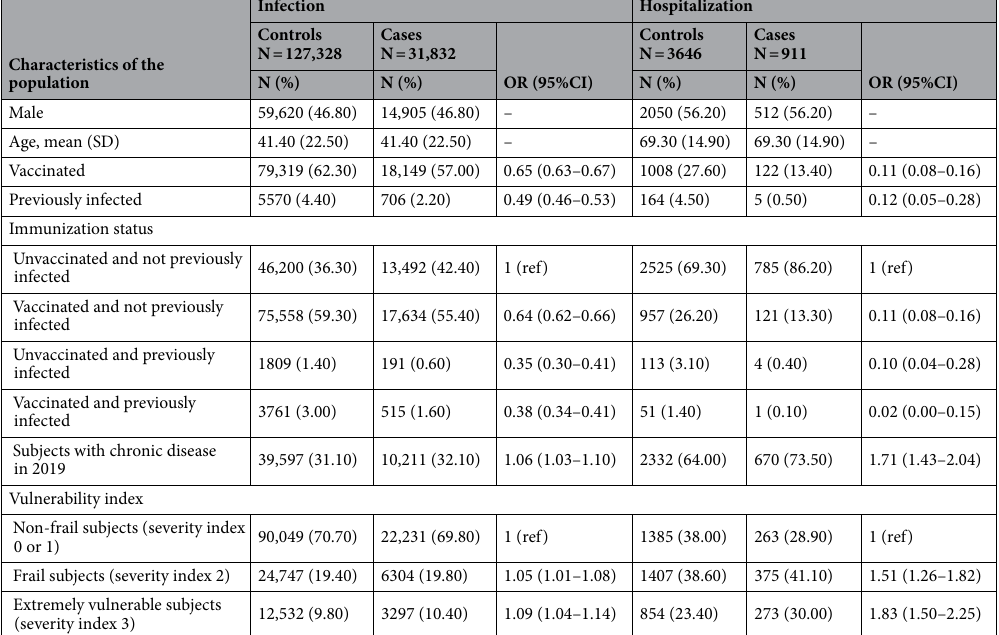
Table 1. Distribution of cases and controls’ characteristics of in the two studies, odds ratios (OR) and corresponding 95% confidence intervals (95%CI) derived from univariable conditional logistic regression.